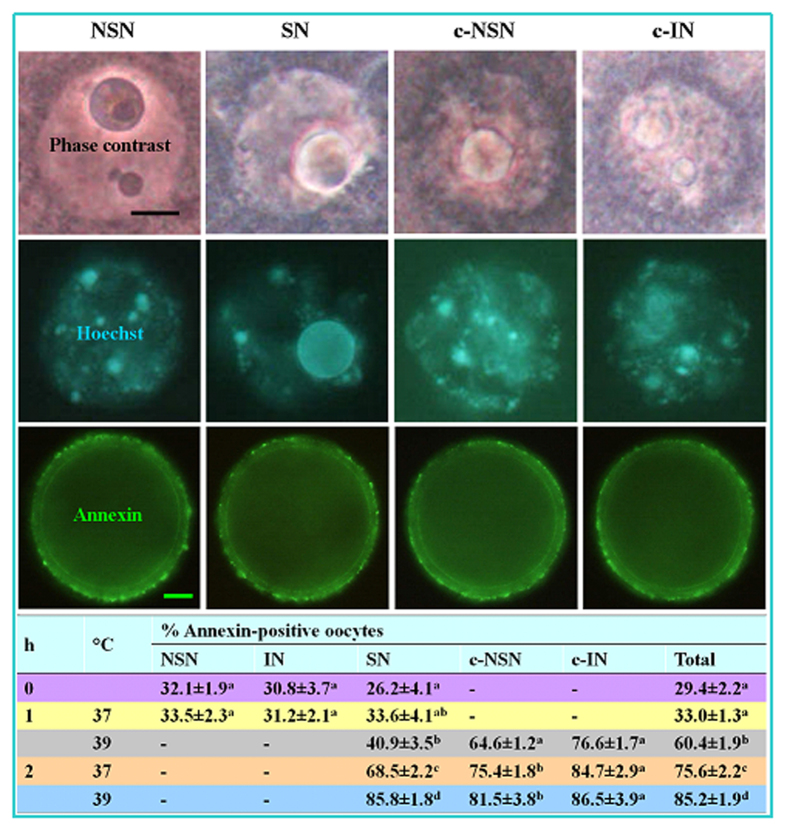
Annexin-positive oocytes with different chromatin configurations after OH of prepubertal mouse ovaries at different temperatures for different times.Photographs in the same column show the same oocytes observed under phase contrast (original magnification ×1300, scale bar is 10 μm) and fluorescence after Hoechst (×1300) and annexin (×400, scale bar is 15 μm) staining, respectively. Photographs in different columns show oocytes with NSN, SN, c-NSN and c-IN configurations, respectively. The table shows percentages of annexin-positive oocytes with various chromatin configurations after OH at 37 or 39 °C for 1 or 2 h. a–d: Values without a common letter in their superscripts differ (P < 0.05) in the same column. Each treatment was repeated 4-5 times with each replicate containing about 30 oocytes.